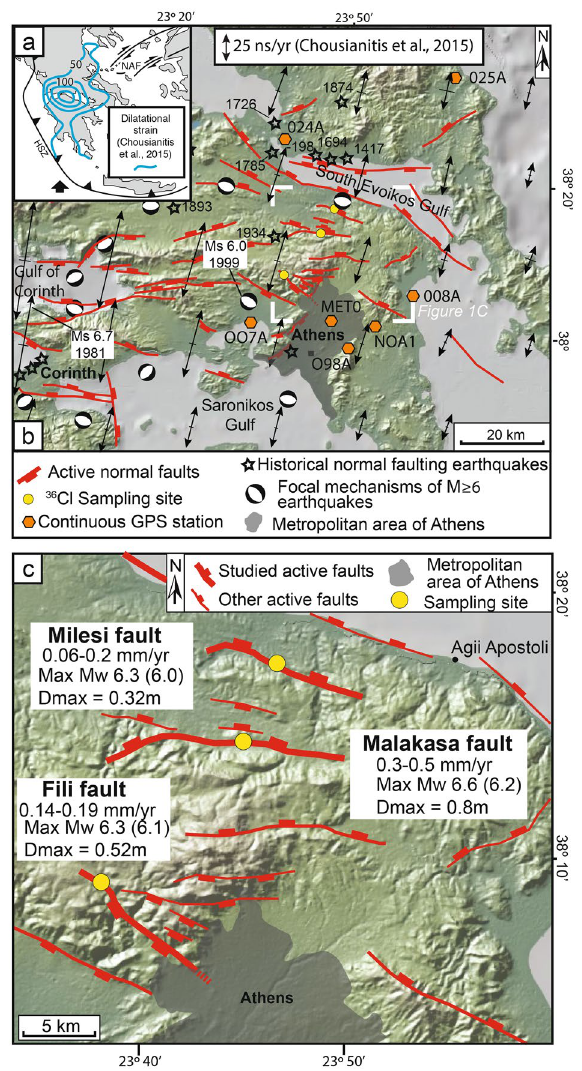
Figure 1. Location maps of the study area. ( a ) Regional setting of Greece with dilatational strains from GPS data (from Chousianitis et al. 10 ). HSZ: Hellenic Subduction Zone; NAF: North Anatolian Fault. ( b ) Fault map with red lines indicating active faults, modified from Deligiannakis et al. 49 and Konstantinou et al. 34 . Black lines with double arrowheads are principal horizontal strain-rate axes on a uniform grid inverted from the GPS velocity field, averaged over a grid used for calculations (see Chousianitis et al. 10 , for details). Focal mechanisms of earthquakes are from Chousianitis et al. 10 and references therein. Historical earthquakes are from Grutzner et al. 46 , and reference therein. Yellow circles are locations of the 36Cl sampling sites. ( c ) Detailed fault map of Attica, with highlighted the sampled faults (attributes are from Deligiannakis et al. 49 , magnitudes in brackets are from Konstantinou et al. 34 ; fault traces are modified from Deligiannakis et al. 49 and Konstantinou et al. 34 ). Thick red lines are the sampled faults; thin red lines are other active